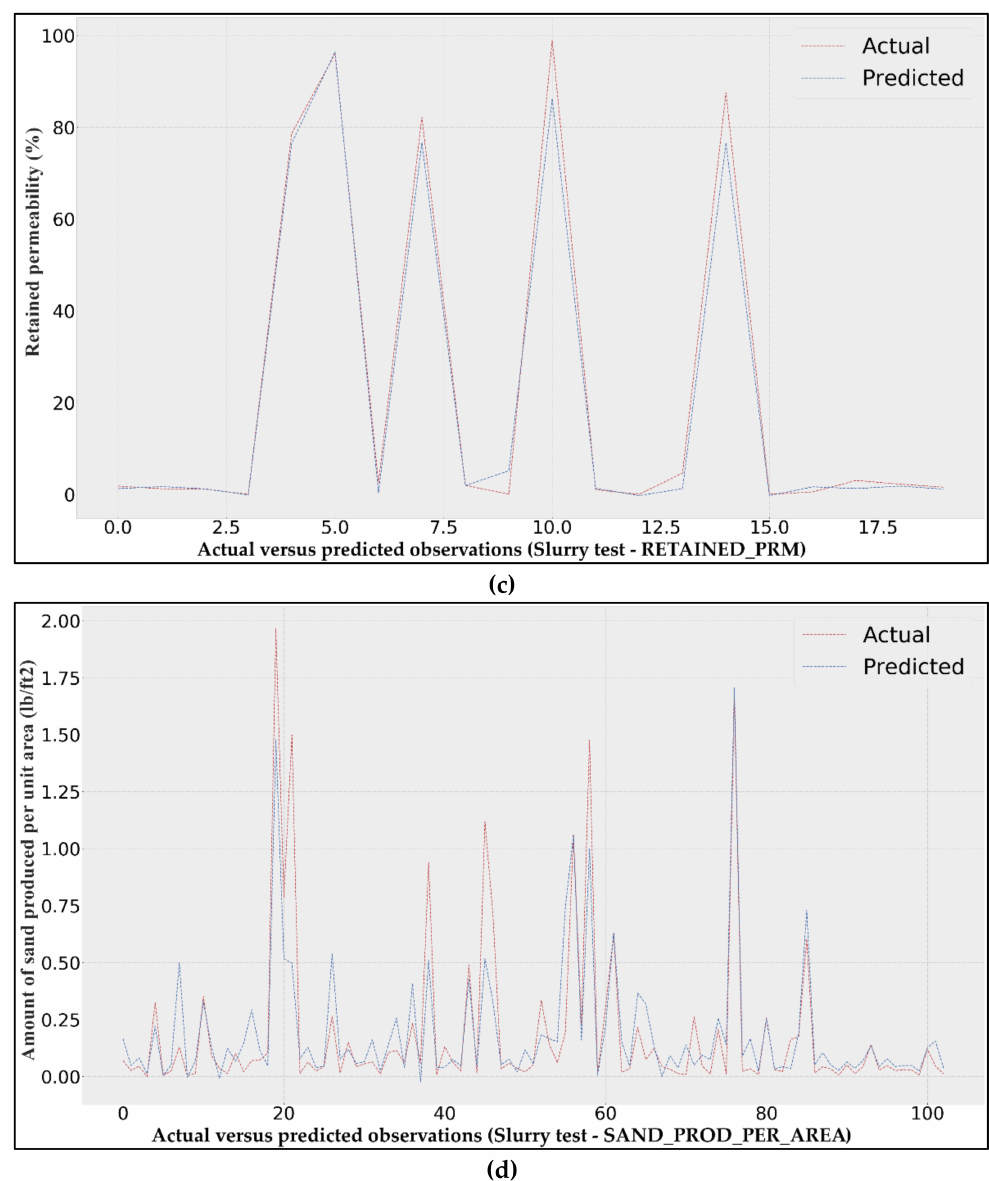
Figure 6. The actual versus predicted plot of model 5 for the slurry test: ( a ) The plot for plugging sign; ( b ) the plot for the amount of sand produced in grams; ( c ) the plot for retained permeability; ( d ) the plot for the amount of sand produced per unit